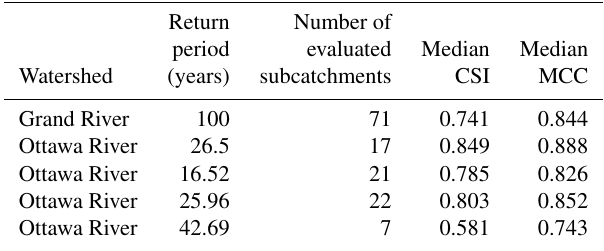
Table 4. Binary comparison